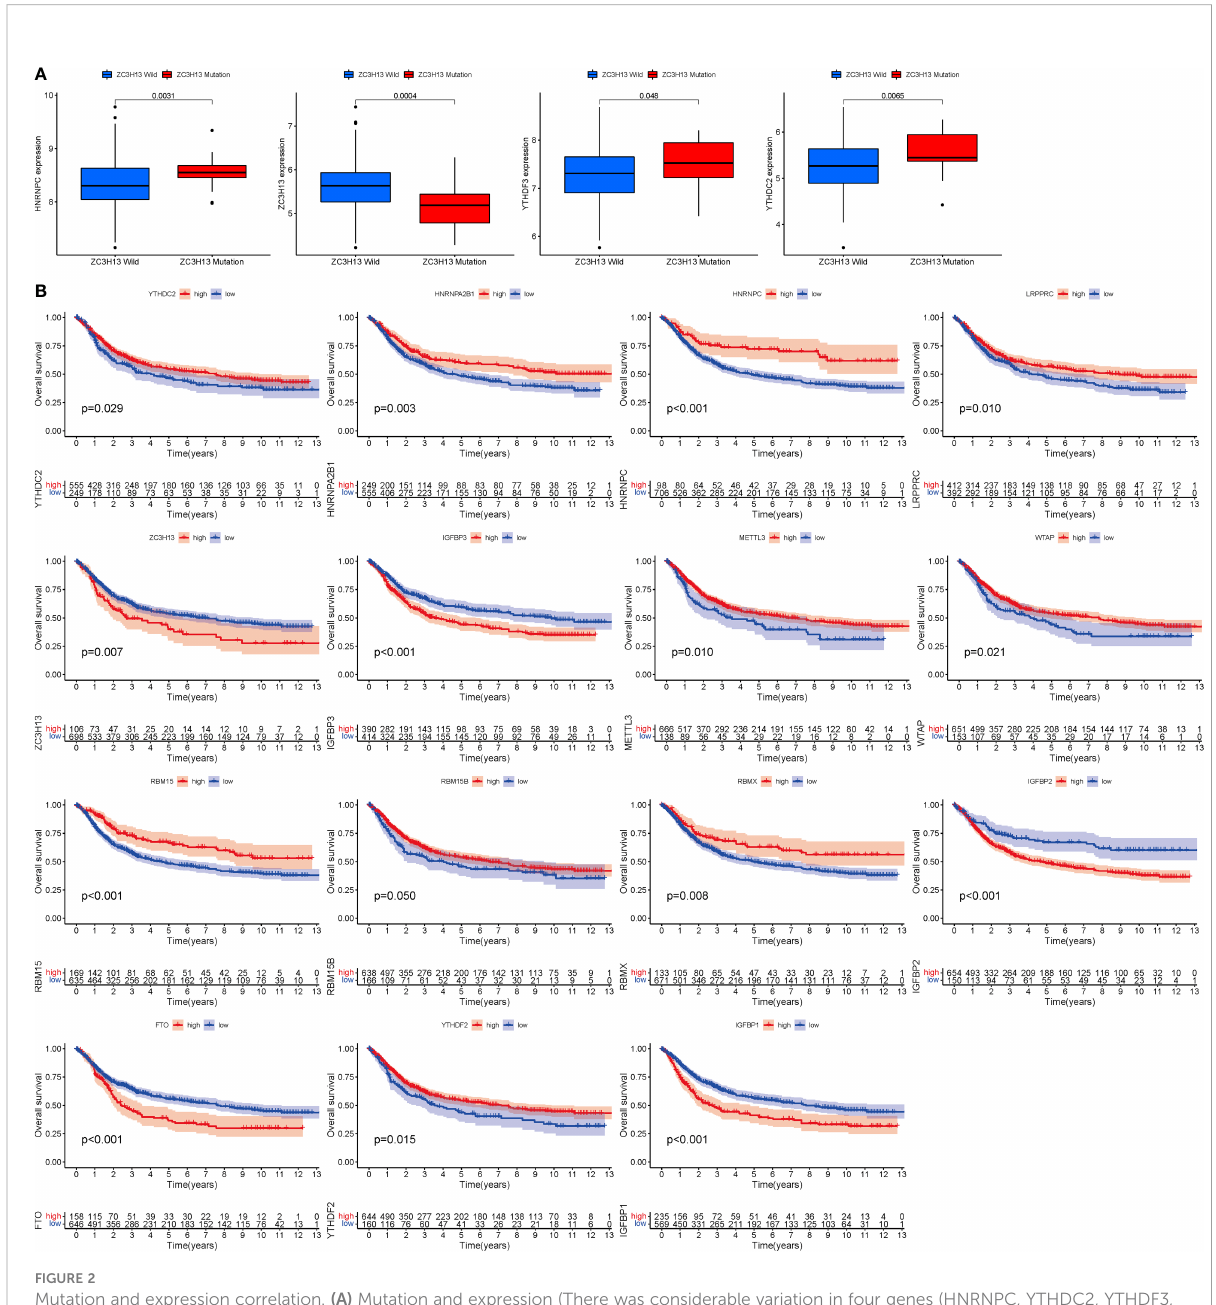
FIGURE 2 Mutation and expression correlation. (A) Mutation and expression (There was considerable variation in four genes (HNRNPC, YTHDC2, YTHDF3, and ZC3H13). (B) m6A survival analysis (All of these m6a-genes were associated with STAD